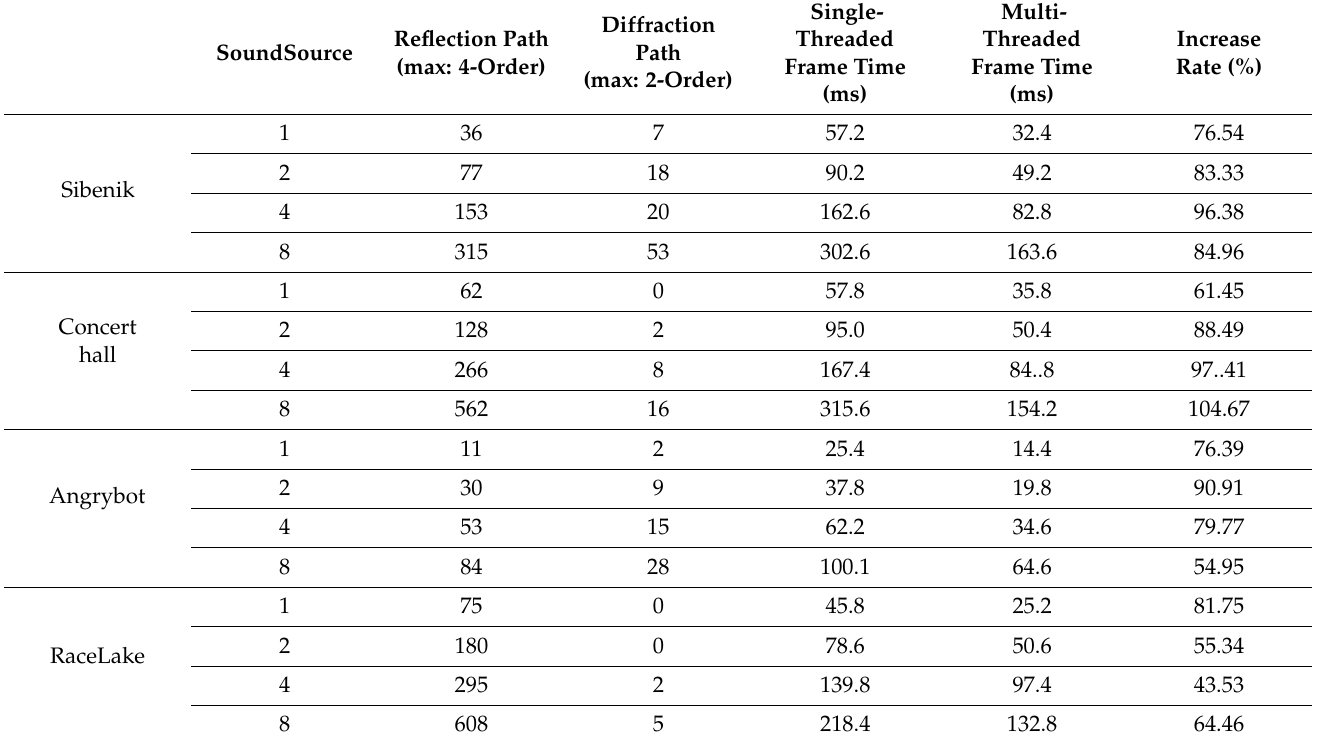
Table 2. Performance comparison of single-threaded and multi-threaded algorithms for four